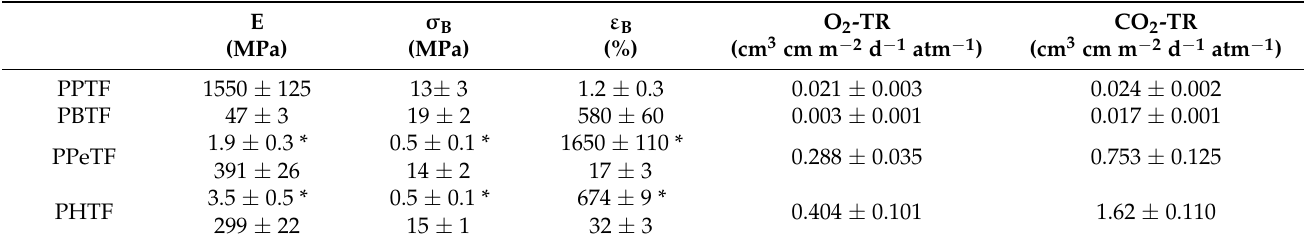
Table 3. Mechanical and gas permeability characterisation data of the compression-moulded films.